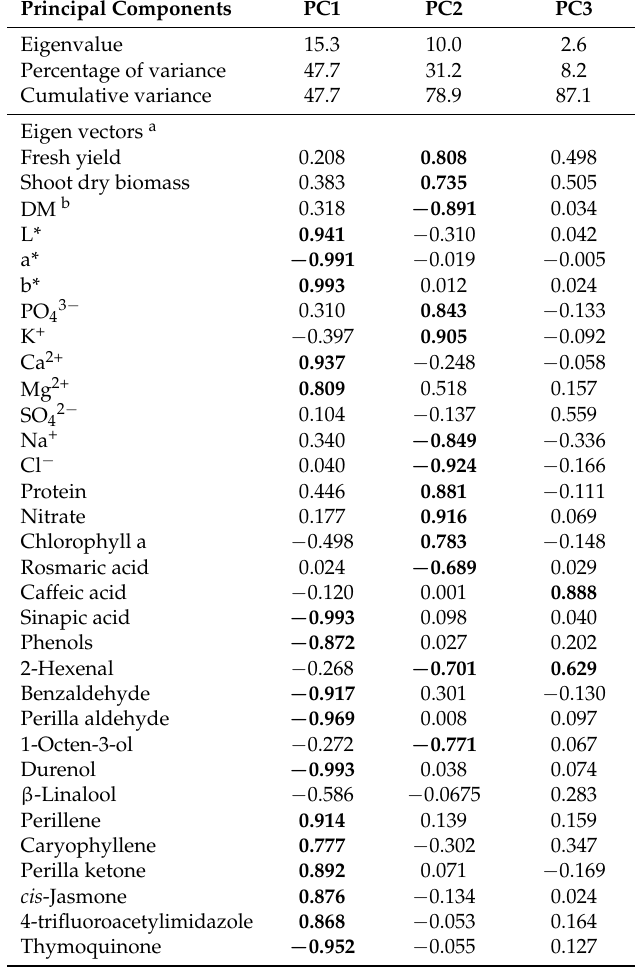
Table 5. Eigenvalues, relative and cumulative proportion of total variance, and correlation coefficients for each nutritional trait with respect to the three principal